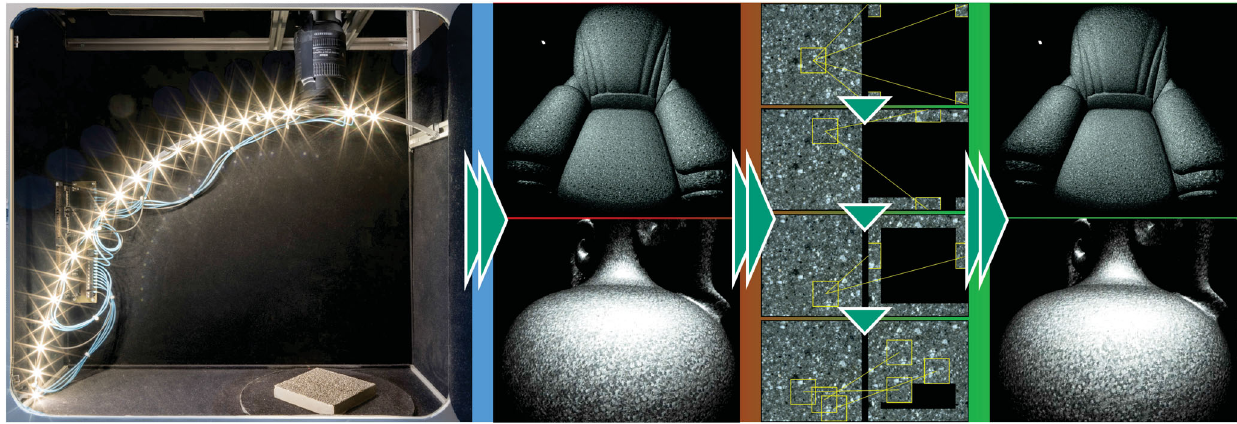
Fig. 2 From measured optical material behavior (4D textures with seams and repetitions) via synthesis of a set of seamless and non-repetitive 4D texture variations to real-time 3D rendering on arbitrary 3D geometry, without texturing